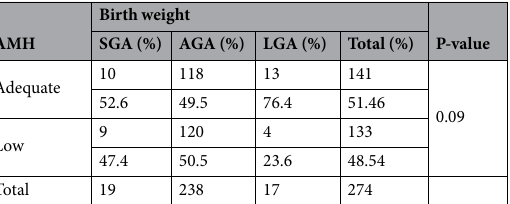
Table 4. Association between AMH and Birth weight. AMH: Anti-mullerian hormone; P-value: Referring to Fisher exact